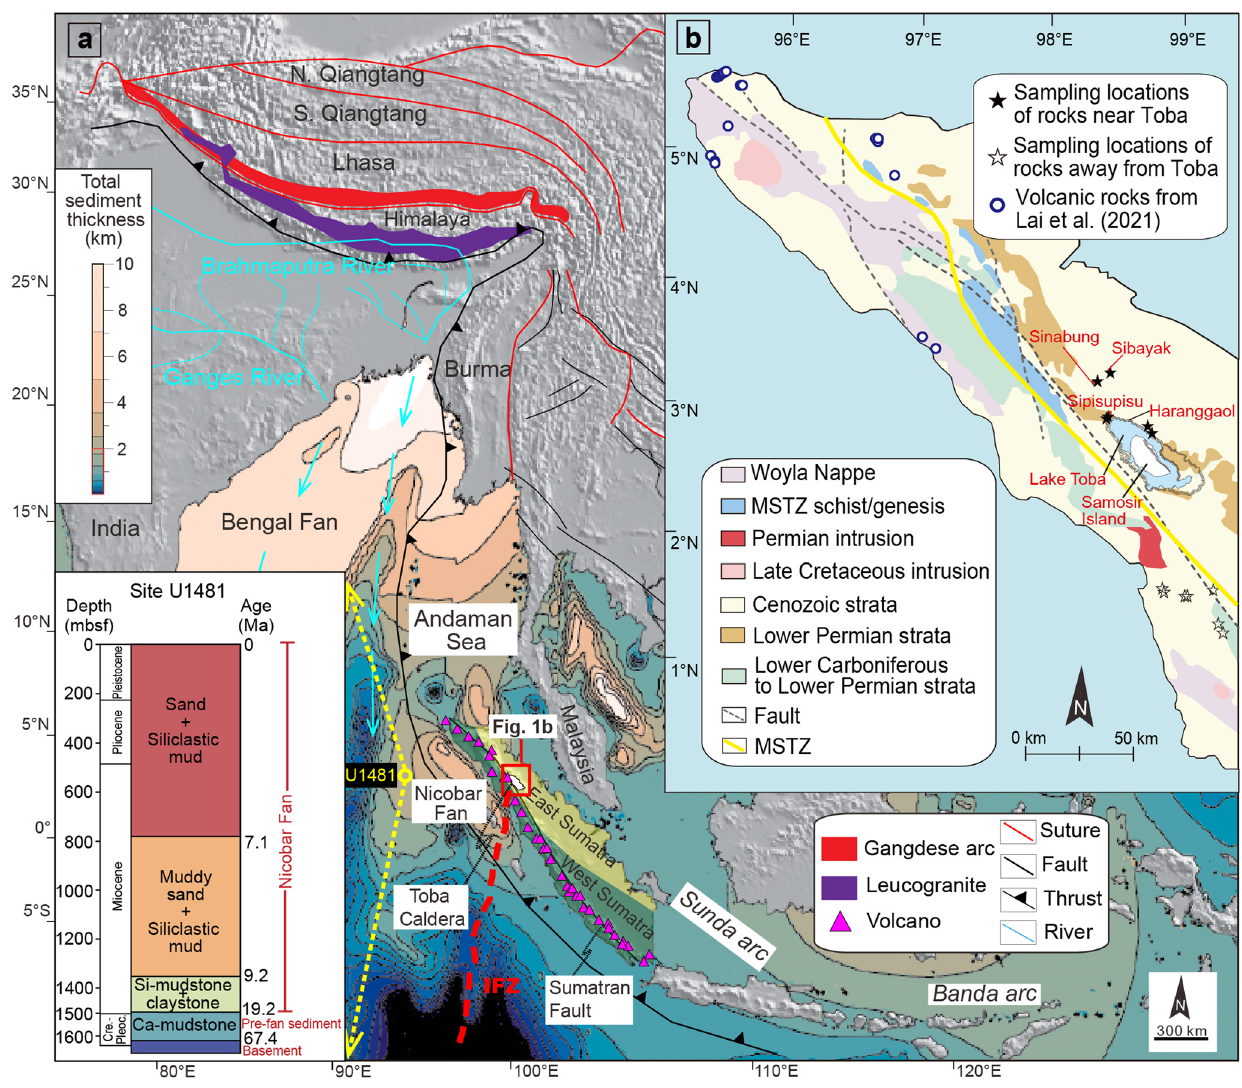
Fig. 1 Schematic geological map of the Southeast Asia and sampling locations in northern Sumatra. a Overview of the Southeast Asia. A base map of the total sediment thickness is taken from ref. 55 . Stratigraphic column of Site U1481 in the lower left corner is modi fi ed from ref. 23 . b A simpli fi ed geological map of northern Sumatra and the Toba Caldera. Sampling locations are marked and classi fi ed according to their distance from the Toba Caldera. IFZ- Investigator Fracture Zone, MSTZ-Medial Sumatra Tectonic